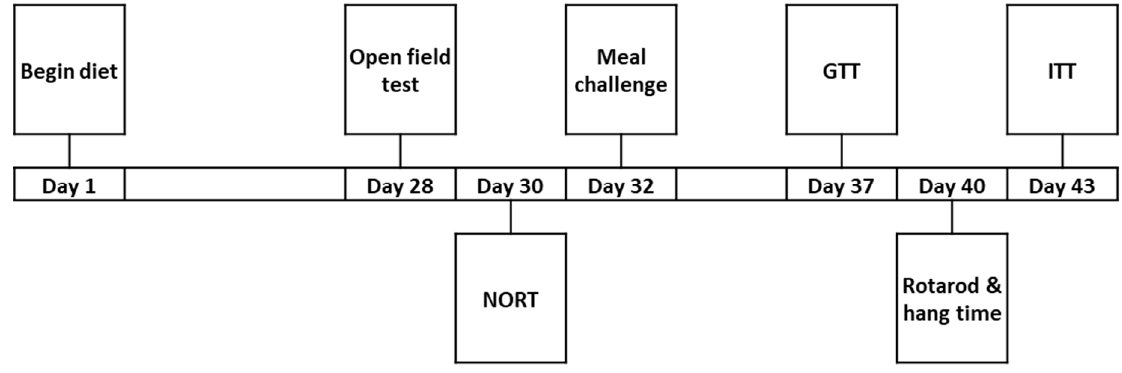
Figure 1. Experimental overview of long-term studies. GTT, glucose tolerance test; ITT, insulin tolerance test; NORT, novel object recognition test.